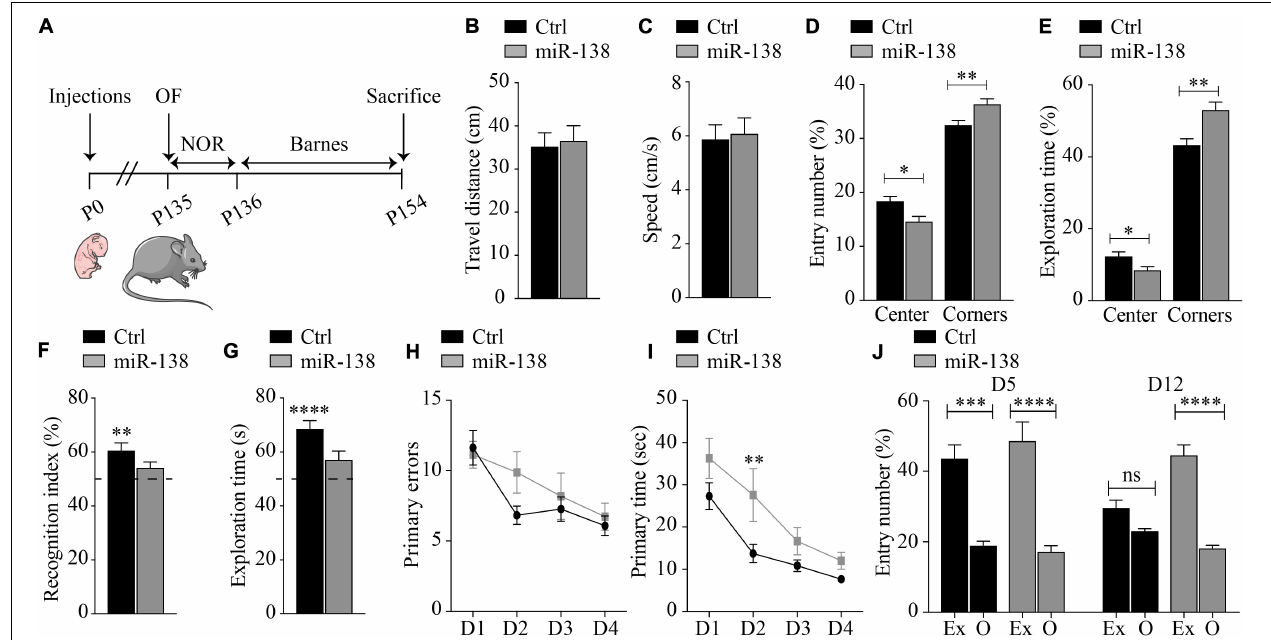
FIGURE 2 | Alterations in learning, memory, and anxiety in miR-138 mice. (A) Experimental outline of the study herein. Open field: (B) travel distance, (C) speed, (D) entry number, and (E) exploration time into the center and the corners by miR-138 ( n = 11) or Ctrl mice ( n = 13). Data show with mean ± SEM: * P < 0.05, ** P < 0.01, *** P < 0.001 (unpaired student t -test). Novel object recognition: (F) recognition index and (G) exploration time of the novel object by miR-138 and Ctrl mice. Data show difference from 50% with mean ± SEM: * P < 0.05, ** P < 0.01, *** P < 0.001, **** P < 0.0001 (column statistics test). Barnes: (H) primary error and (I) primary time for miR-138 mice and Ctrl mice during the 4 days of testing (learning). Data shows in mean ± SEM: ns, non-significant; * P < 0.05, ** P < 0.01 (two-way ANOVA). (J) Entry number in exit (Ex) versus mean of other (O) quadrants during the probe test at day 5 and 12 for Ctrl mice and miR-138 mice. All tests were performed on 30 mice in total ( n = 13 males and n = 17 females). Data shows in mean ± SEM: ns, non-significant; * P < 0.05, ** P < 0.01, *** P < 0.001, **** P < 0.0001 (Kruskal-Wallis